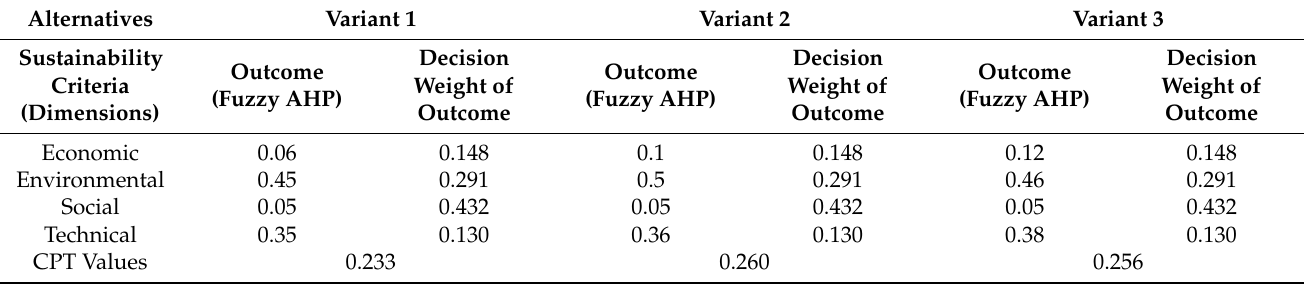
Table 8. Calculation of CPT values for the energy technology variants; decision weights were calculated using http: //psych.fullerton.edu/mbirnbaum/calculators/cpt_calculator.htm (accessed on 25 October